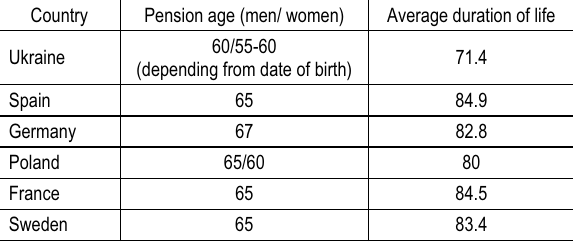
Table 3. Pension age and average duration of life Country